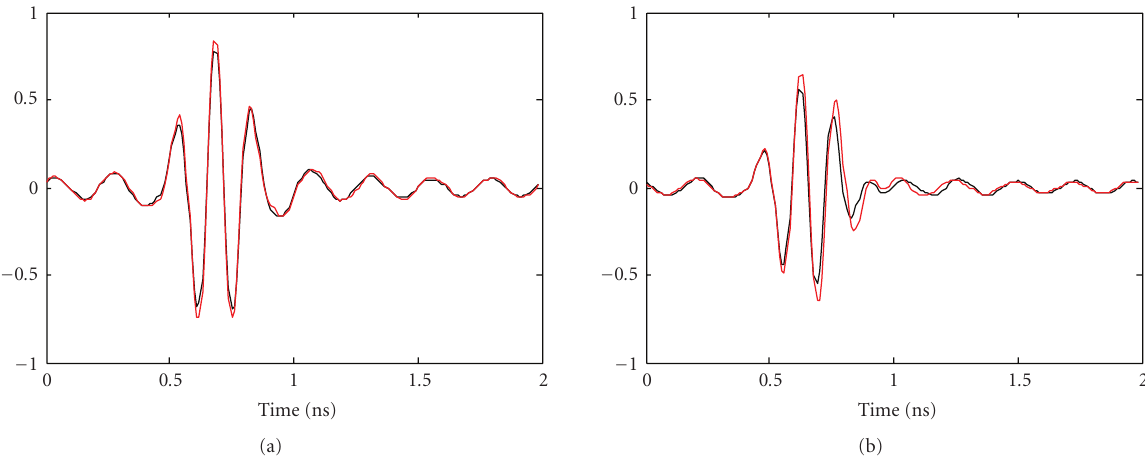
Figure 19: Expected radiated waveform (black line), SC approximation (red line) at (a) ϕ = 180 ◦ and θ = 90 ◦ , (b) θ = 30 ◦